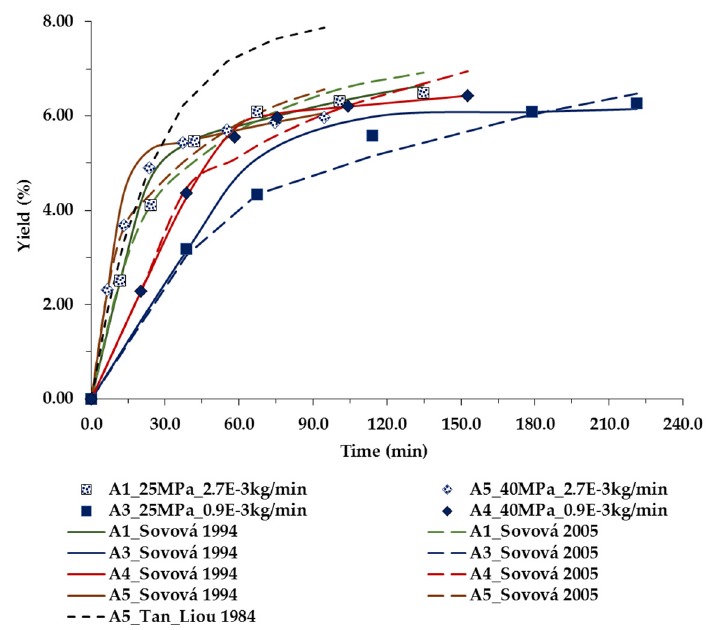
Figure 4. Extraction yield curves representing the influence of pressure (MPa) and CO 2 flow rates (kg/min) at 313.15 K, on RBO yield, as a function of time. The symbols are the experimental data, and line-model predictions.